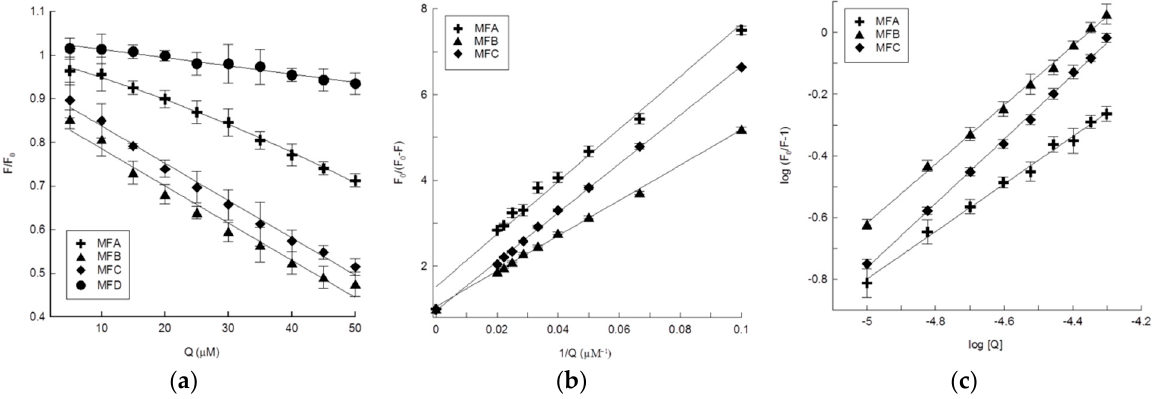
Figure 7. Quenching curves of holo-transferrin (HTF) in the presence of MFA, MFB, MFC, and MFD compounds used in the concentration range from 0 to 50 µM. ( a ) Relative fluorescence intensity (F/F 0 ) was calculated as the ratio of the HTF fluorescence intensity in the presence of compound (F) to the HFT fluorescence intensity before compound addition (F 0 ). ( b ) Stern–Volmer curves of HTS-compounds complex ( c ) logarithmic plots of HTF fluorescence quenching. The HTF was excited at 295 nm, the measurements were done at 23 °C. The results are presented as an average ± standard deviation.